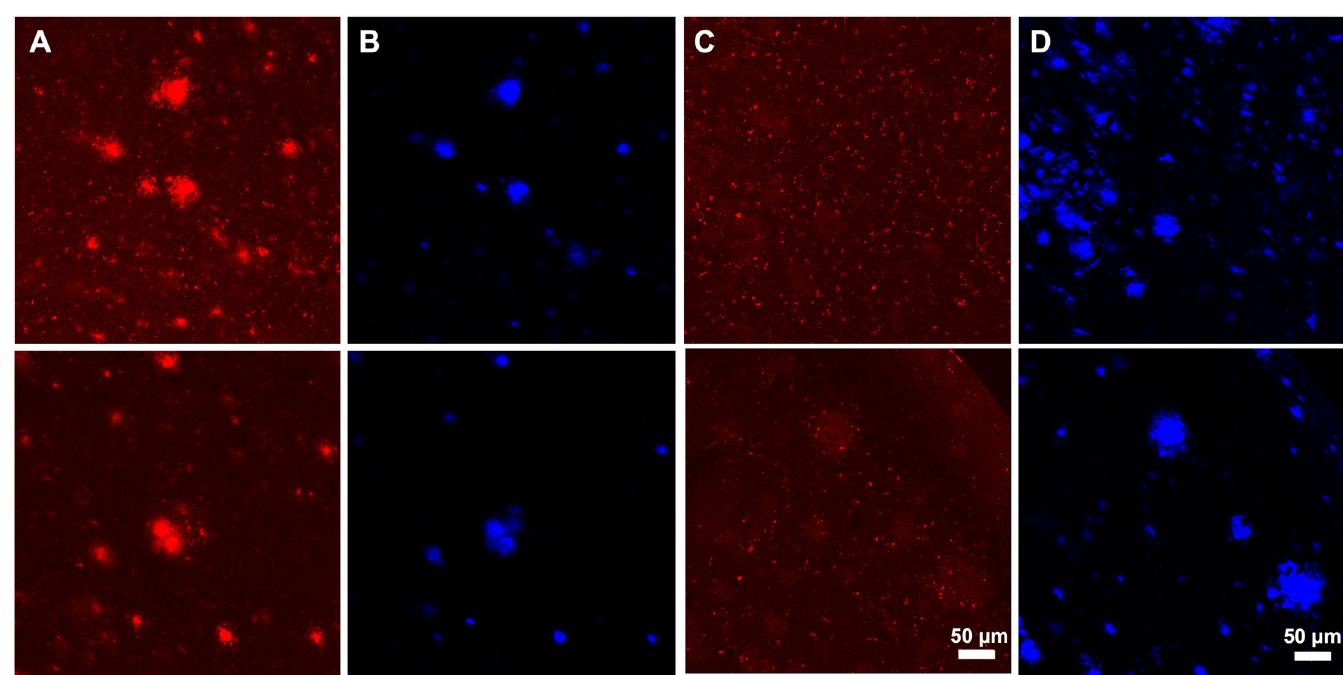
Fig 8. Representative immunofluorescent confocal microscopy of ex vivo APP/PS1 positive mouse brain sections. Mice brain sections were stained with X34 and M1 P96H -Triplet-647 to label the amyloid plaques. Representative 647 channel ( A ) and X34 channel ( B ) microscopy images of the ex vivo brain sections labeled with M1 P96H -Triplet-647. Representative 647 channel ( C ) and X34 channel ( D ) microscopy images of the ex vivo brain sections without M1 P96H -Triplet-647 labeling.